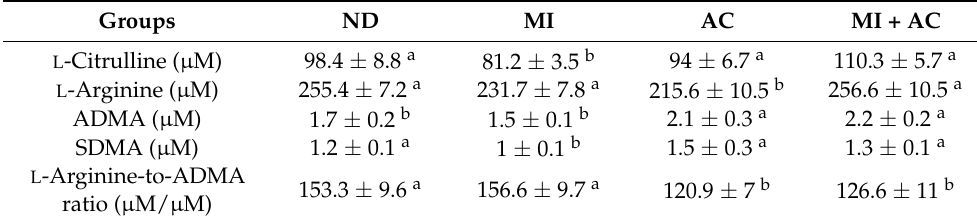
Table 3. Plasma levels of NO-related parameters in 12-week-old male